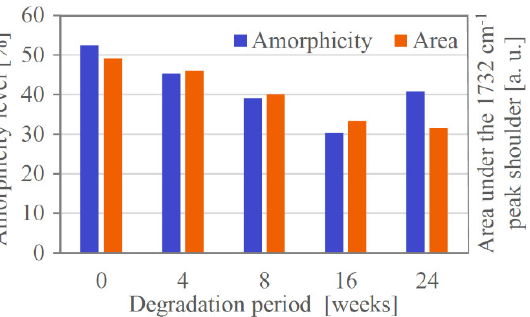
Figure 9. Comparison of the change in PPDX crystallinity (determined by differential scanning calorimetry) and the reduction in the 1732 cm −1 peak shoulder.